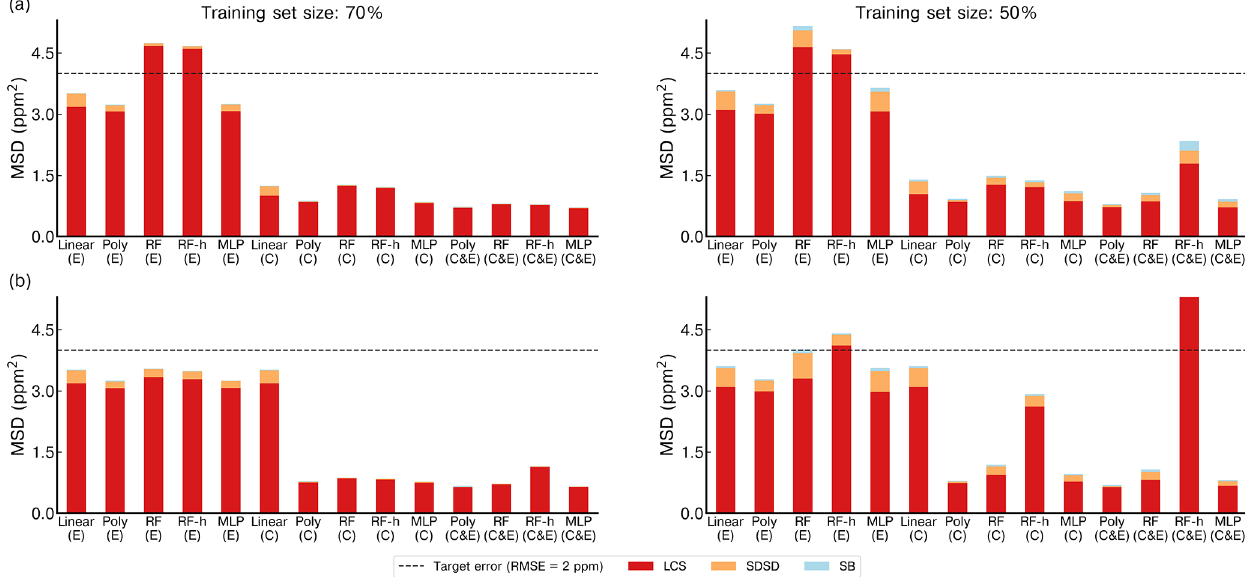
Figure 7. Comparison of the mean standard deviation (MSD) across the different models on the test set for a 20-fold cross-validation. (a) Models with only voltage of TGS sensors as input. (b) Models including environmental variables and voltage of TGS sensors as input. Left panels show the performances on a training set size of 70% and right panels a training set size of 50% of the total observations. The stacked bars show the contribution of each component of the MSD to the total error. The lack of positive correlation weighted by σ (LCS) is shown in red, the difference in the magnitude fluctuation (SDSD) in orange and the simulation bias (SB) in green. Notation for the models is the same as for Fig. 6. Table 3. Comparison of error for reconstructing spikes in experiment 2, using the two best models (polynomial and MLP) trained with the best training set configuration during experiment 1. Mean RMSE a Mean RMSE b Difference 1 2 (ppm) (ppm)